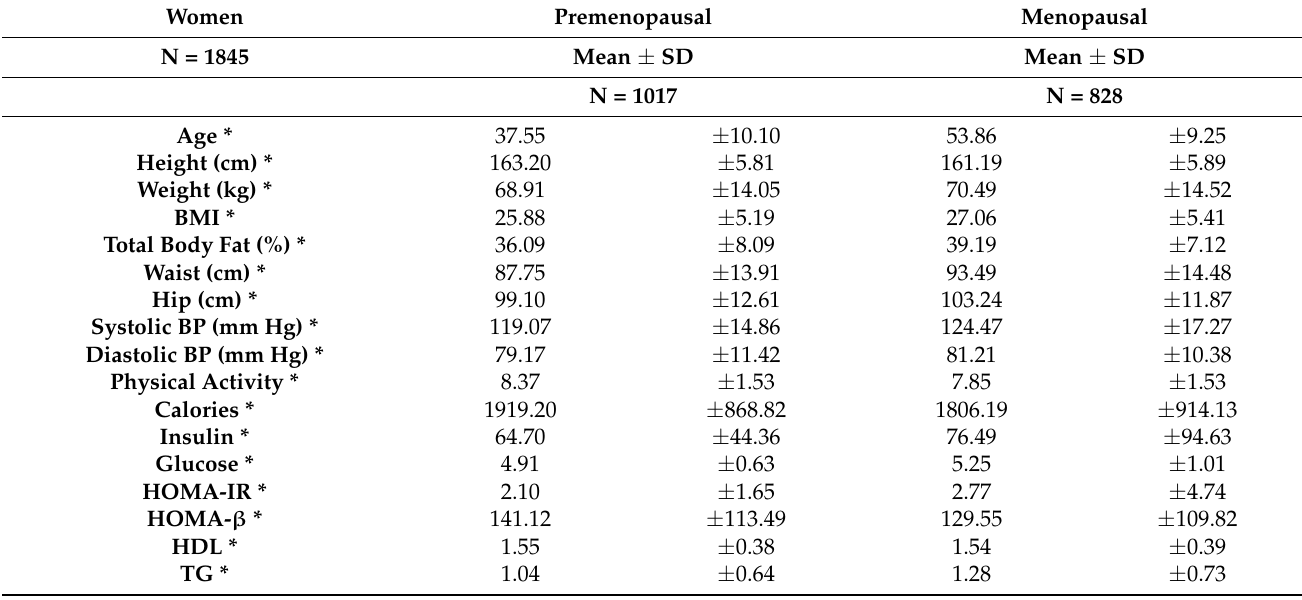
Table 2. Physical and metabolic characteristics of premenopausal and menopausal women.